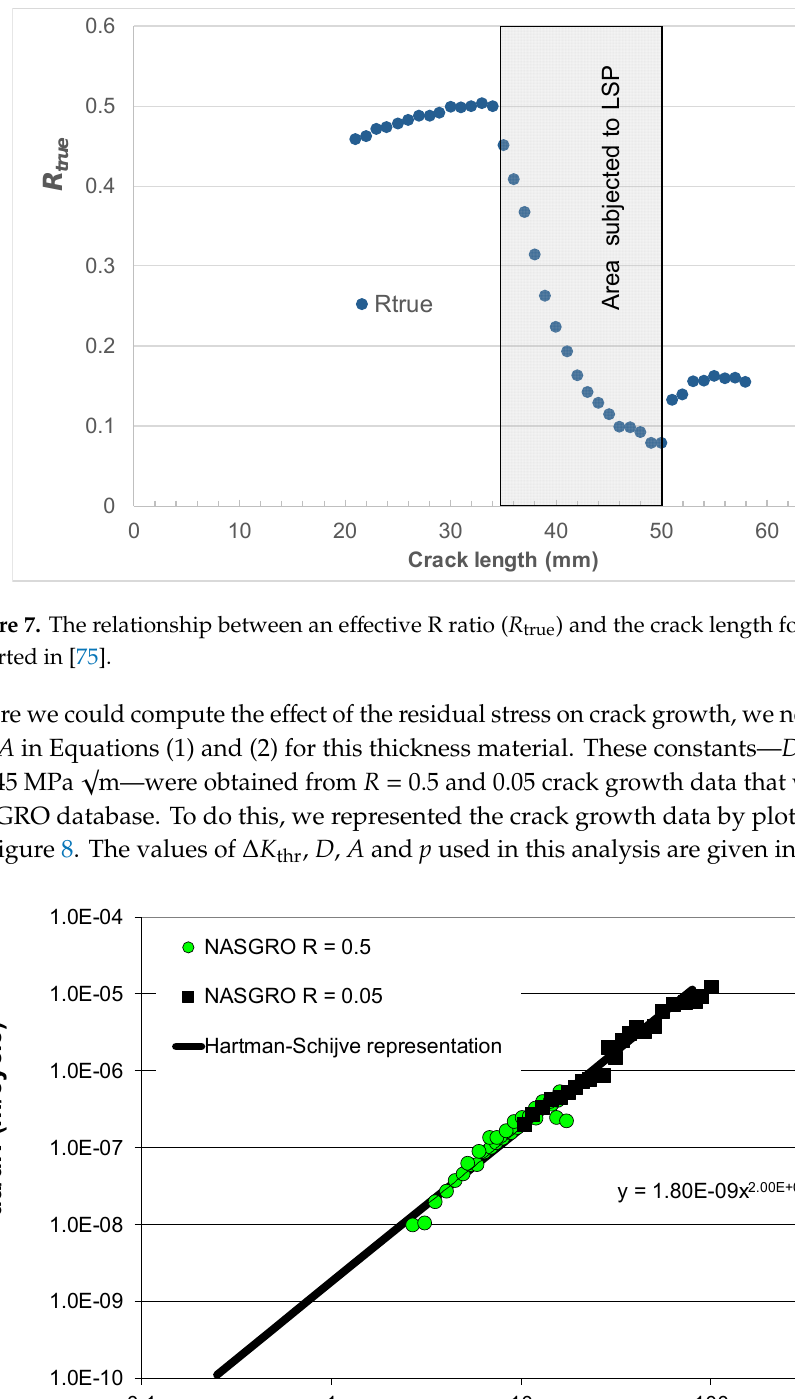
Figure 6. The various stress intensity factor versus crack length curves given in [75].